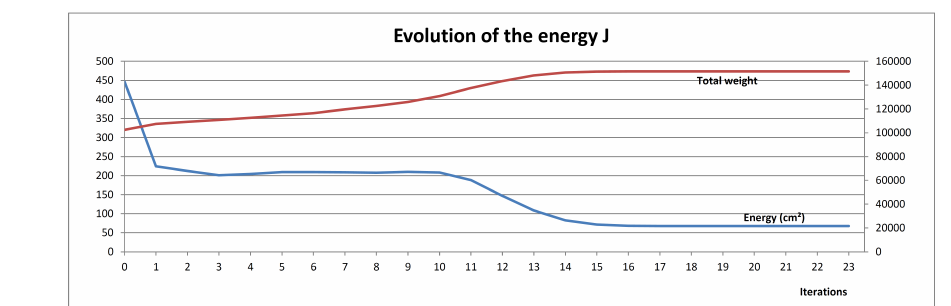
Table 13. Final errors of the intrinsic parameters of real point cloud #2